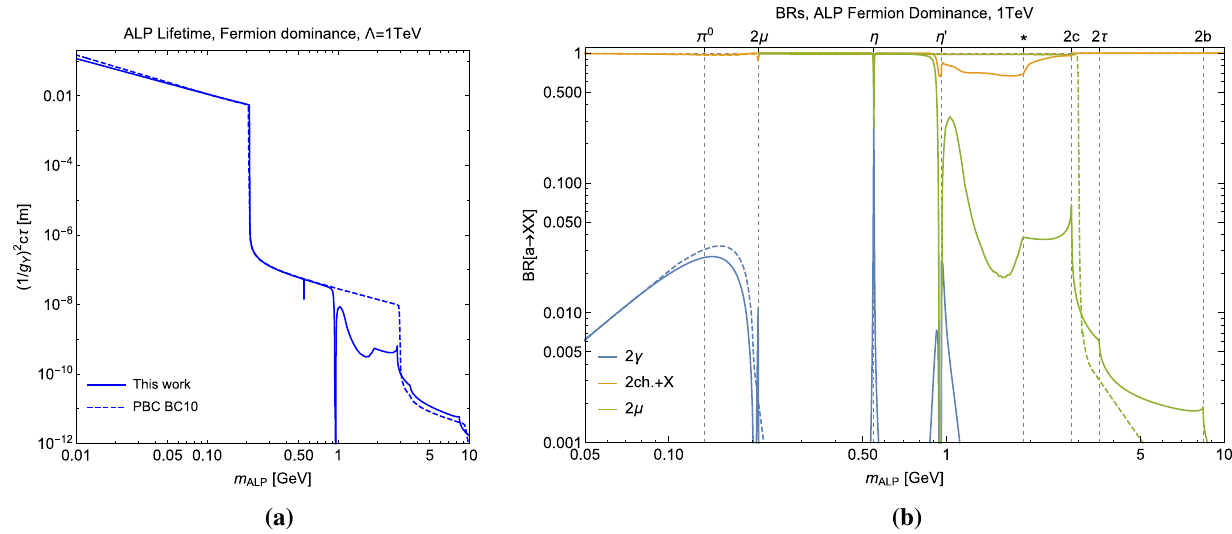
Fig. 13 Lifetime (left) and branching ratios (right) for an ALP coupled to fermions, used in Fig. 11. For comparison we plot as dashed lines the corresponding values used for BC10 in the PBC